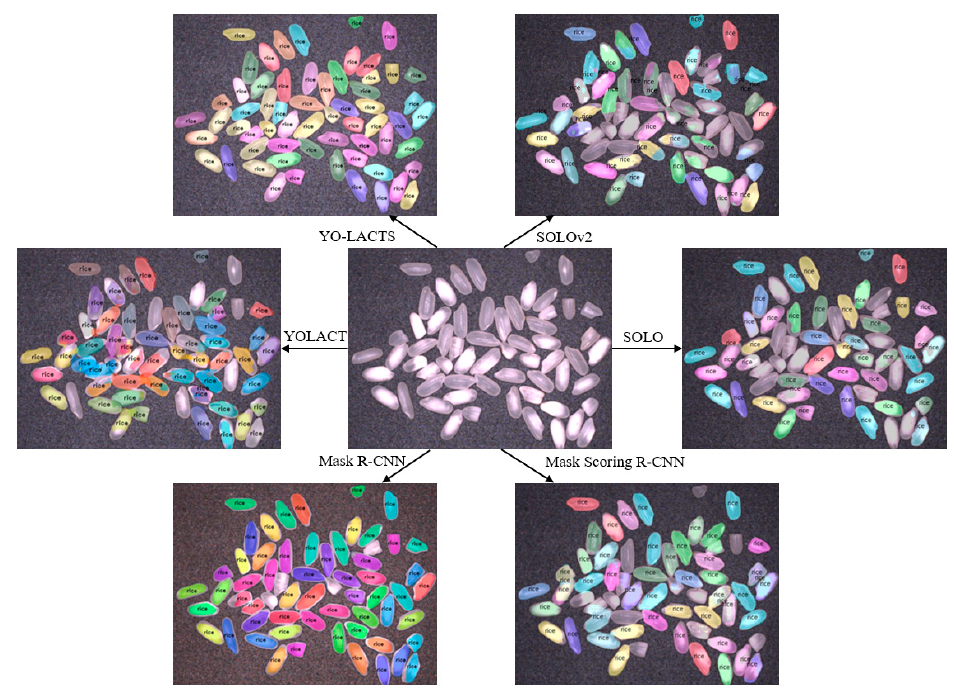
Figure 10. Comparison of YO-LACTS and other algorithms on complex polished rice image segmentation. Table 5. Statistic results of rice grain types before improvement.